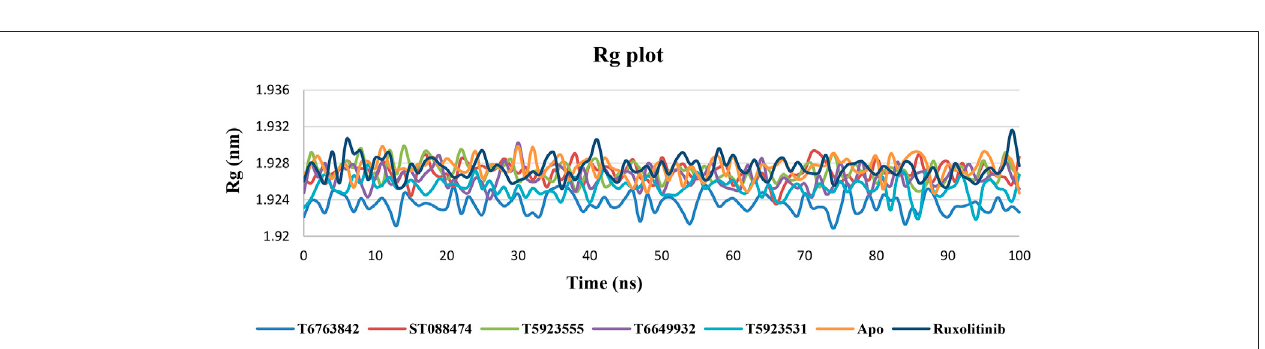
Frontiers in Pharmacology |